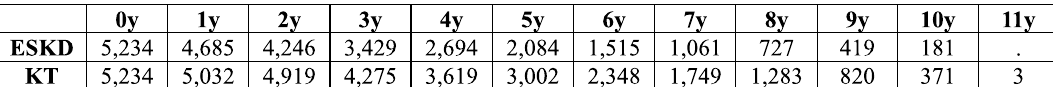
Figure 2. Cumulative risk for incident depression in KT and ESKD group. Abbreviation: ESKD, end-stage kidney disease; KT, kidney